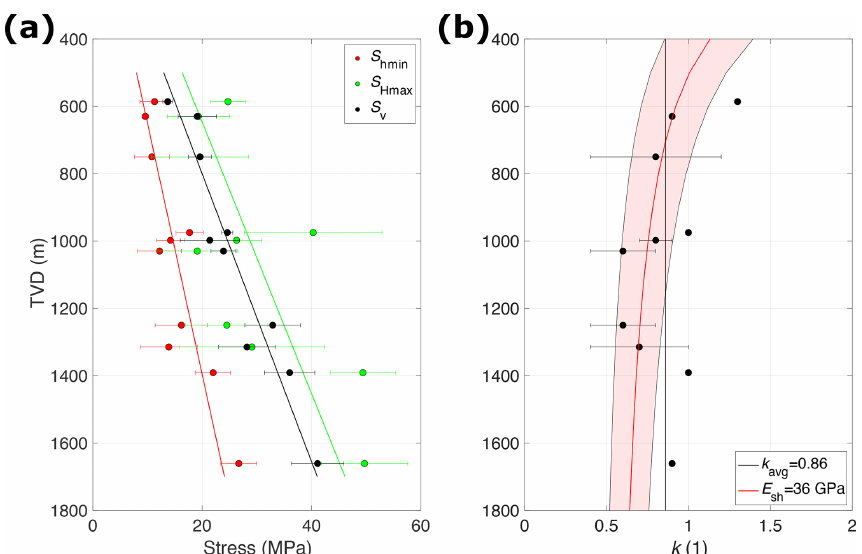
Figure 5. (a) In situ stress magnitudes recorded across the greater Ruhr region based on averaged values from each test location (differenti- ation was made for values from different depth levels in the same coal mine) with trend lines computed based on Eqs. (7), (8), and (9) (see Table 3 for the actual values; TVD – true vertical depth); (b) mean stress ratio, k (i.e. ratio of average horizontal stress and the vertical stress), based on the averaged stress magnitudes recorded across the greater Ruhr region (see Table 3 for actual values). The average k of 0.86 based on hydrofracturing test results acquired from this study is marked with a solid black line. For comparison, k computed based on the approach by Sheorey (1994) for Young’s modulus, E sh , of 36 ± 11GPa, based on laboratory measurements on core samples from the Westphalia coal mine (MeSy, 1994), is presented with solid red line and area shaded in red represents its standard deviation.